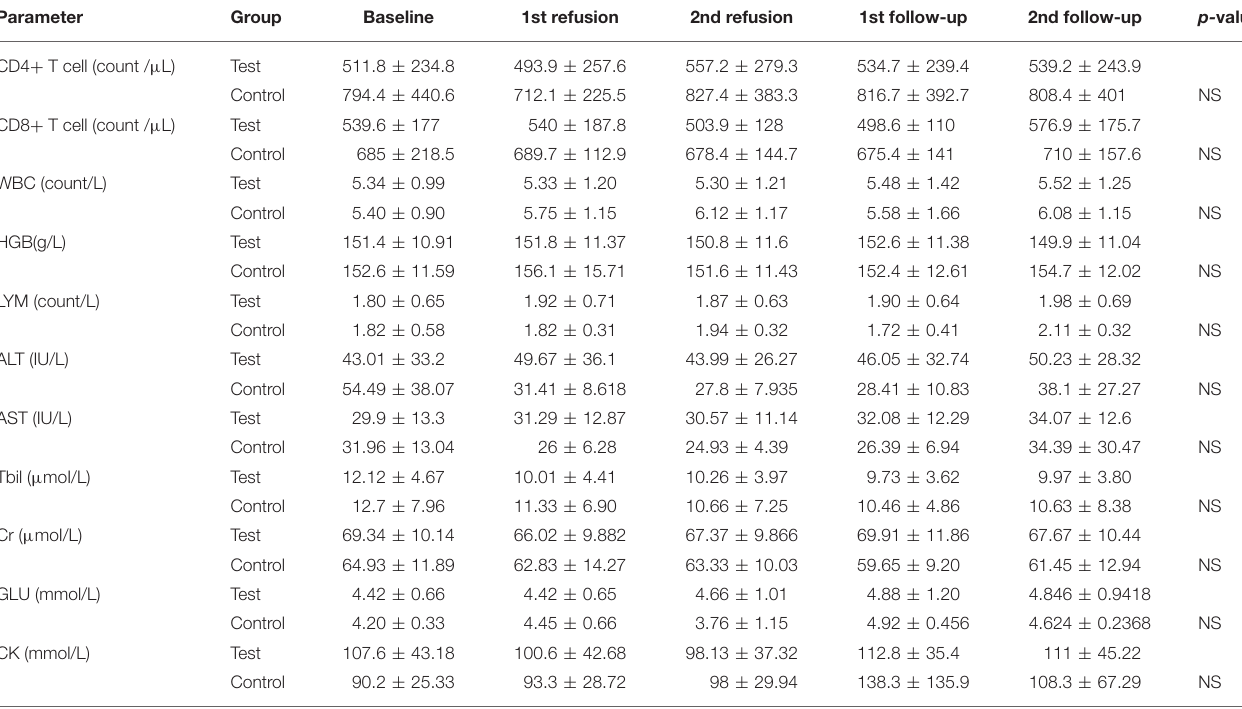
TABLE 3b | Safety: the changes of all the parameters of laboratory evaluations.